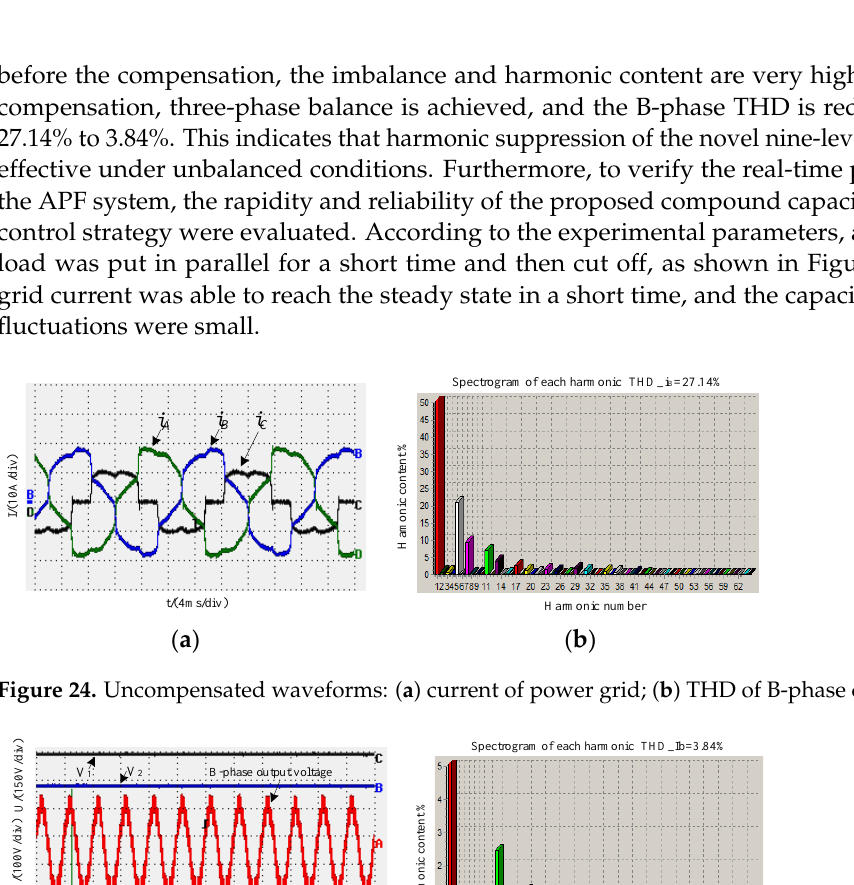
Figure 23. Compensated waveforms: ( a ) current of power grid; capacitor voltage and output voltage, ( b ) THD of B-phase current.